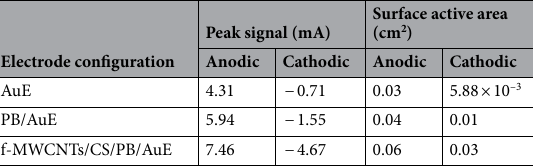
Table 2. Surface active area and peak signals of AuE, PB/AuE and modified f-MWCNTs/CS/PB/AuE.